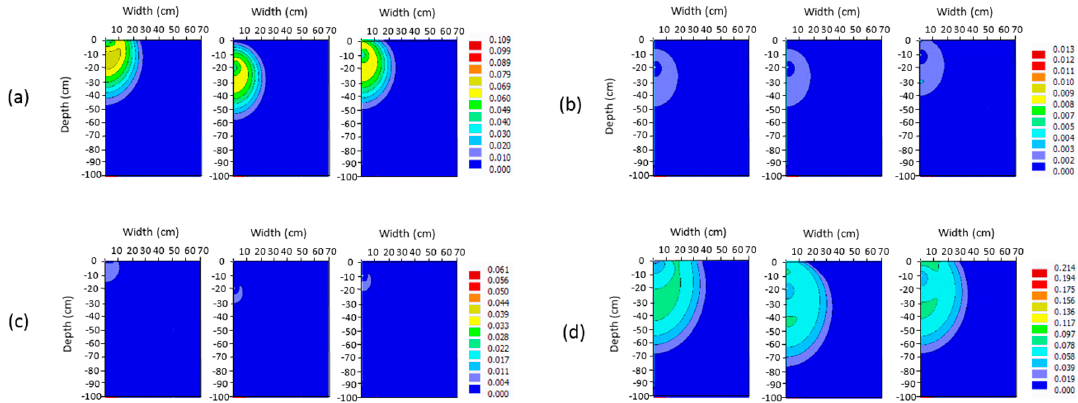
Figure 4. Fertilizer distribution at the end of the simulation period ( t = 40 days) for strategy C in sand with DI and SDI systems and emitter at 10 and 20 cm depths ( a : potassium, b : phosphorus, c : ammonium, and d : nitrate, unit: mg cm − 3 ) .